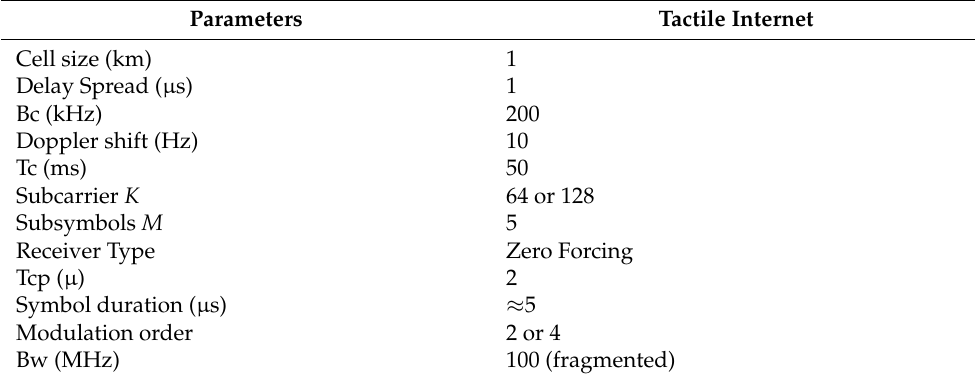
Table 1. Channel and GFDM parameters for tactile internet application [4].